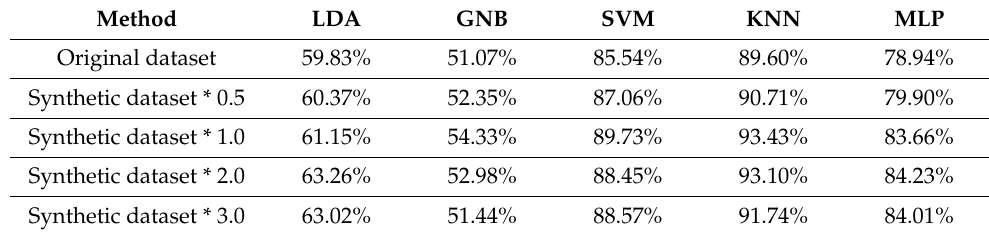
Table 5. Classification accuracy of each classification model under different generation scales.